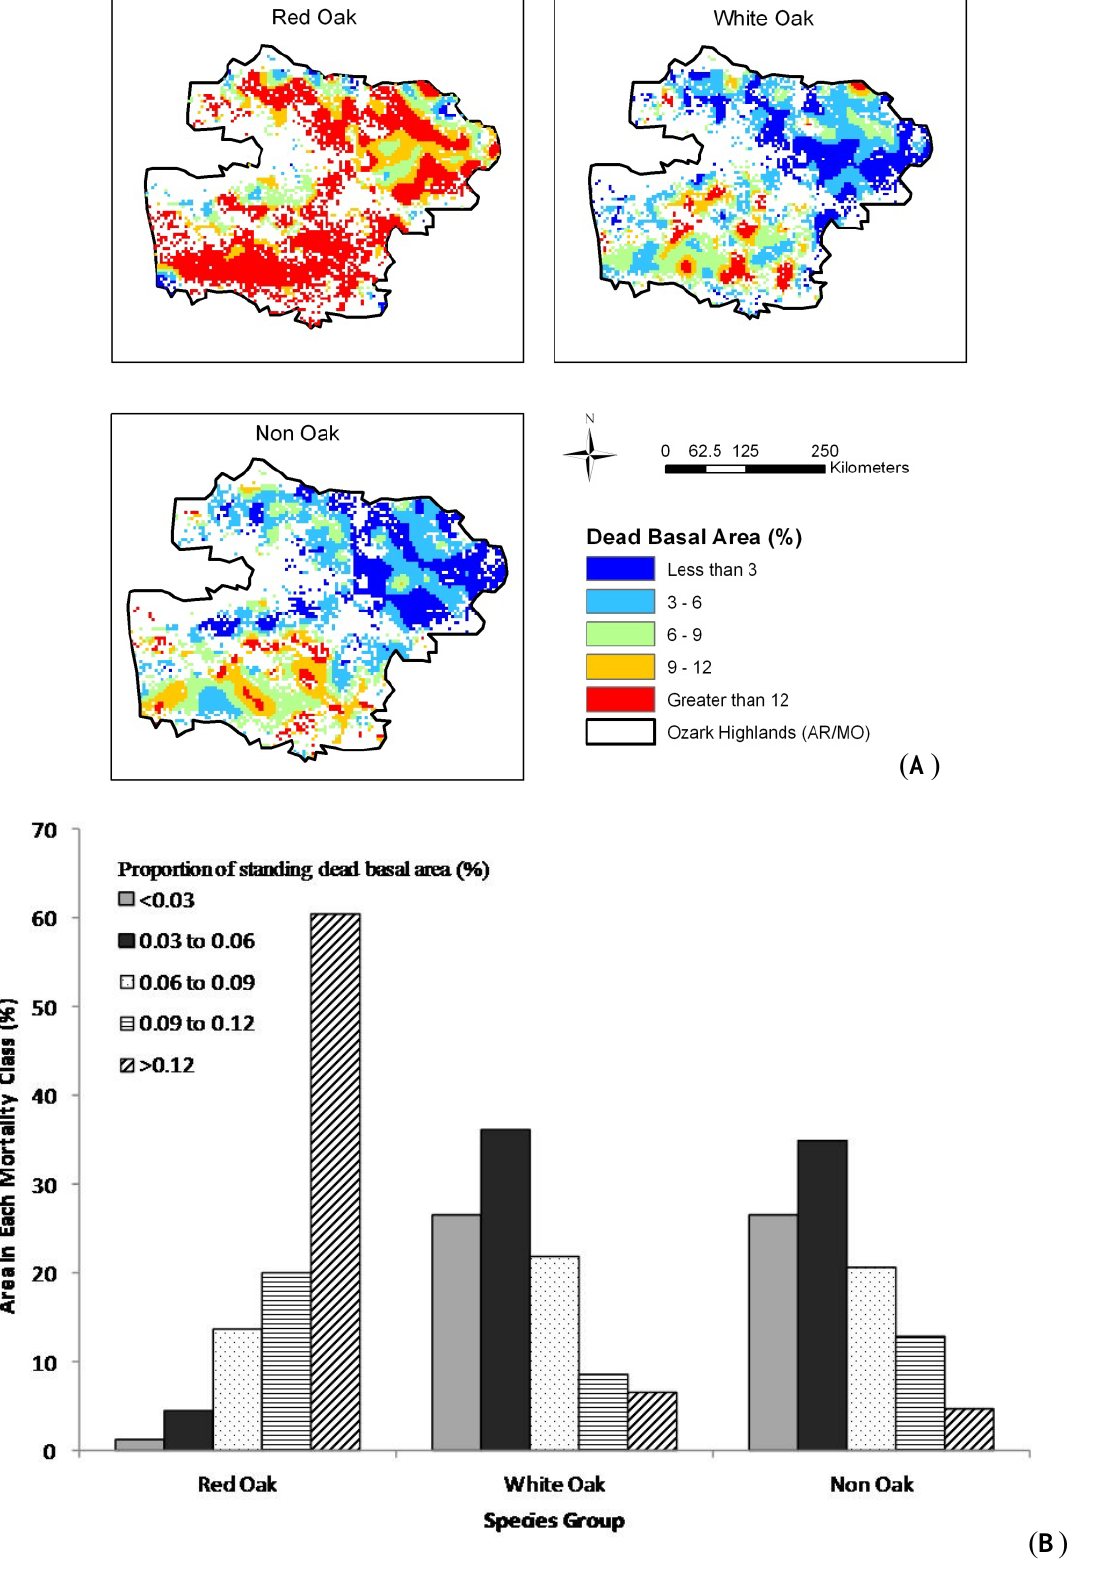
Figure 4. ( A ) Spatial trend, by mortality group for the Ozark Highlands and ( B ) area in each mortality group by species group,